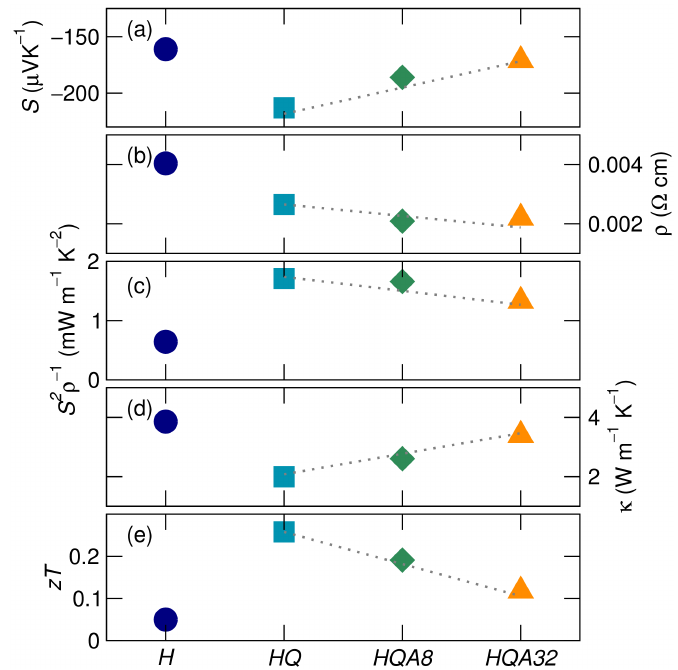
Figure 7. Thermoelectric physical properties for heat-treated samples with treatment identified on the x -axis. ( a ) The Seebeck coefficient is greatly enhanced for sample HQ and reduces with subsequent low temperature annealing; ( b ) resistivity subtly decreases for HQ , and limited change with annealing is observed. As the ( c ) power factor is enhanced, ( d ) thermal conductivity is also reduced, giving HQ has an improved figure of merit, ( e ) zT , which decreases with low temperature annealing, as shown in samples HQA8 and HQA32 . Dashed lines are guides to the